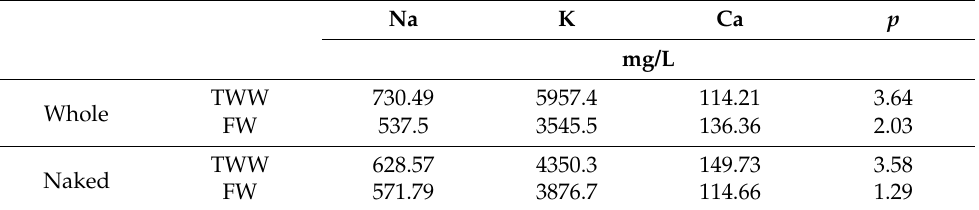
Table 5. Effect of using TWW and FW on mineral composition of the squash seeds.